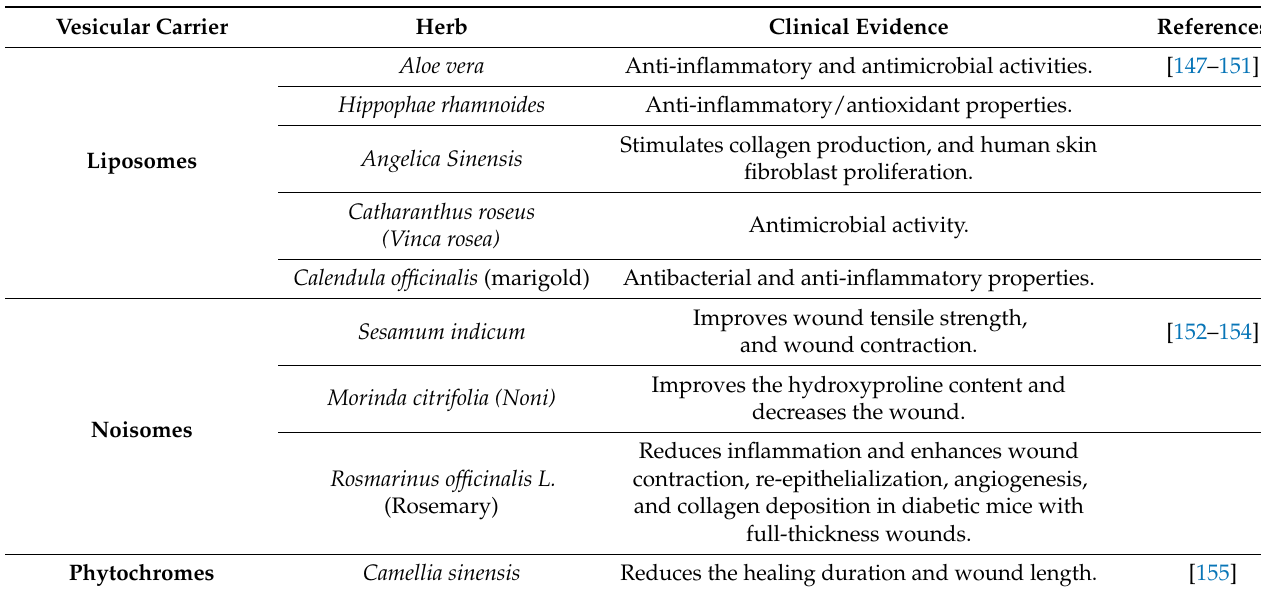
Figure 4. Techniques for the vesicle downsizing of nano/micro vesiculosomes. Table 10. Herbal-loaded vesiculosomes for burn